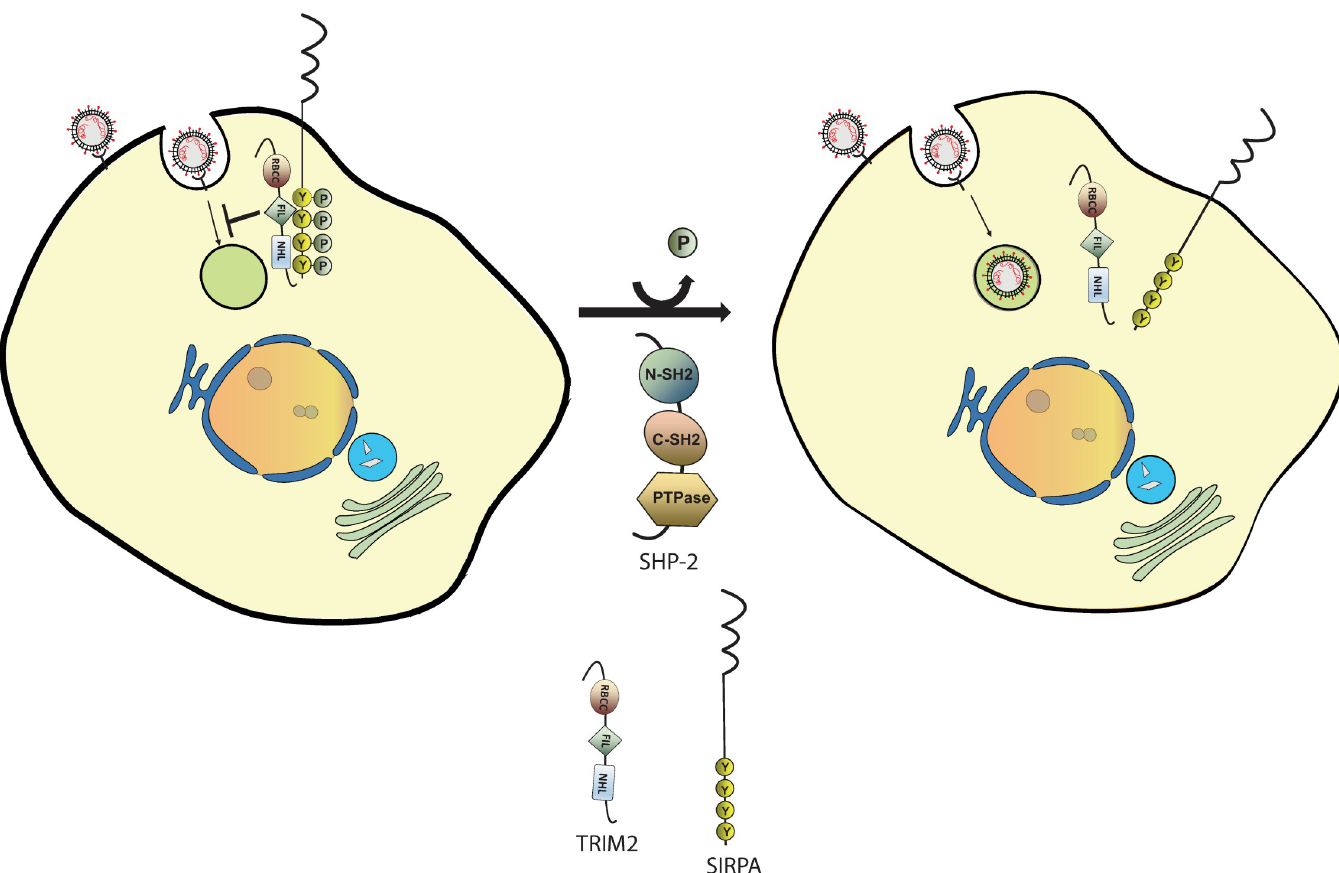
Fig 9. Model for TRIM2–SIRPA inhibition of New World arenavirus infection. TRIM2 and phosphorylated SIRPA form a complex that limits virus endocytosis. Dephosphorylation of SIRPA, possibly by SHP-2, leads to dissociation of the complex and downstream signaling, thereby allowing virus entry to proceed, similar to what is thought to occur when SIRPA-mediated inhibition of phagocytosis is relieved. PTPase, protein phosphatase; SIRPA, signal regulatory protein α